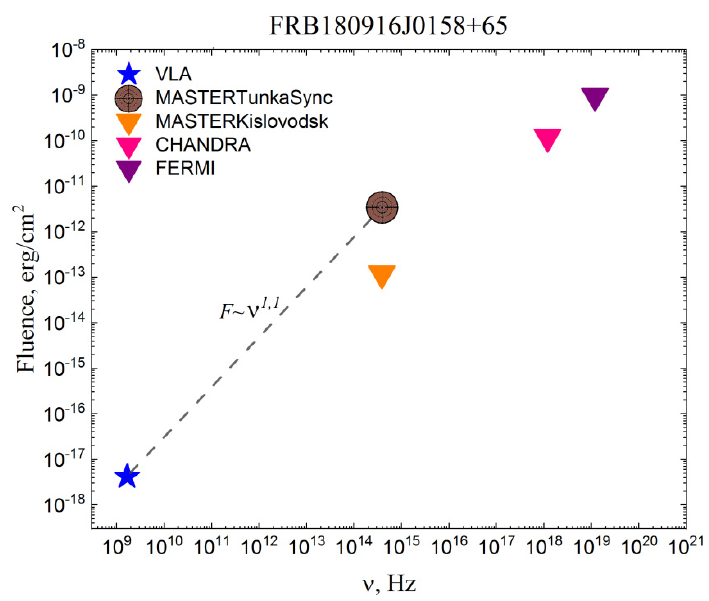
Figure 9. The dependence of the fluence in absolute units on the frequency of observation. This graph shows the limits and typical energies for FRB 180916. Fully filled dots represent FRB 180916. Stars—signal detection, triangles—upper limits. Azure Star—observation of FRB 180916 by the VLA radio telescope dated 23 April 2020 [77] ©VLA2020.MASTER-TunkaSync is synchronous observation of this burst with the MASTER-Tunka optical telescope. Chandra and Fermi GBM are non-simultaneous observations of FRB180916 in the ranges of 0.5–10 keV and 10–100 keV, respectively, Scholz et al. [82,83] .